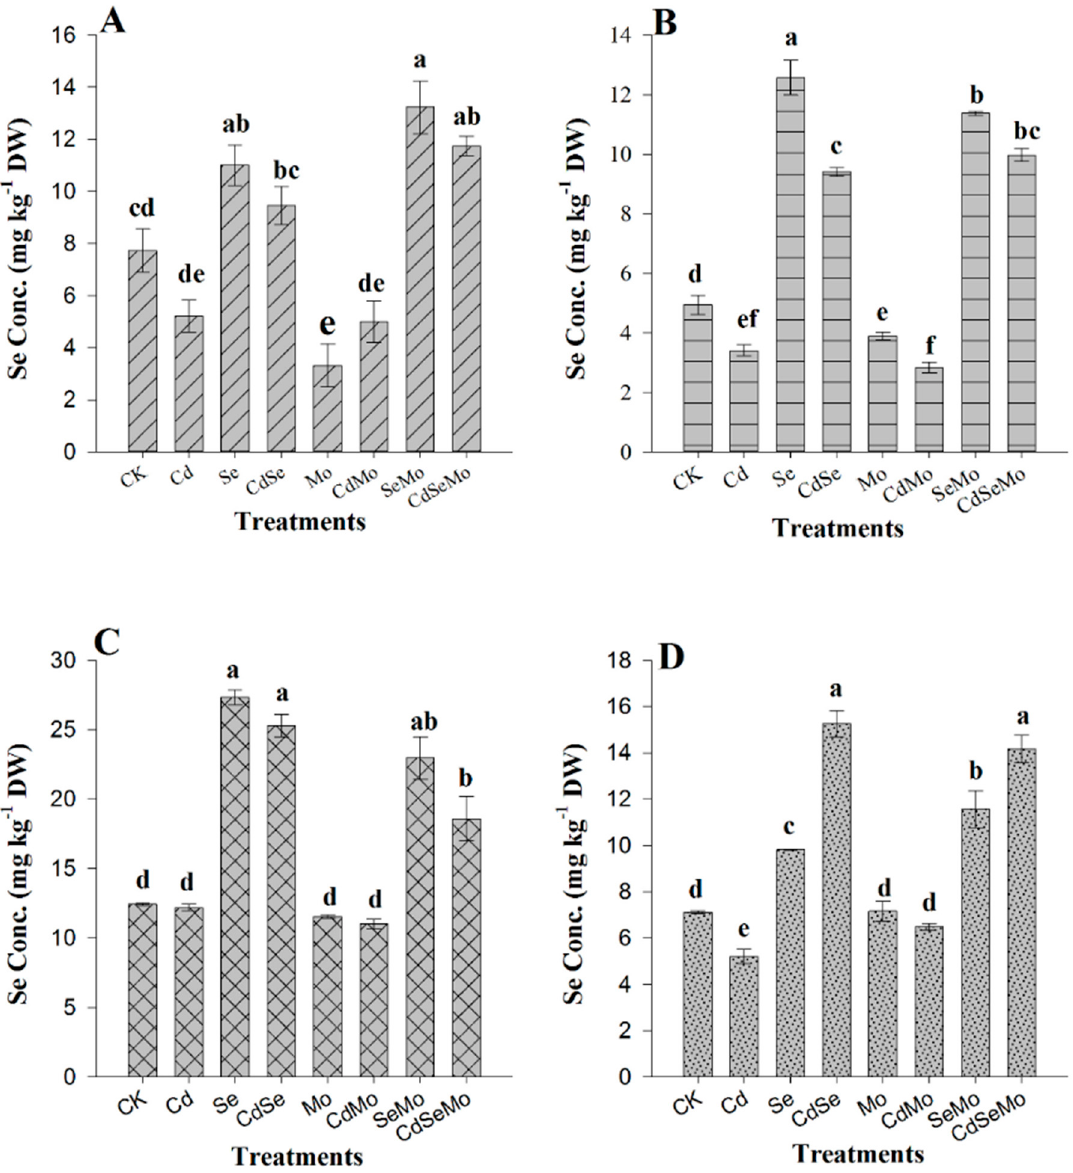
Figure 3. Concentrations of Se in B. napus tissues under different treatment conditions. Se content in root ( A ), stem ( B ), glume ( C ), and seed ( D ) of oilseed rape treated with foliar spray of (1 mg/L) Se and/or (0.3 mg/L) Mo in absence or presence of Cd stress (5 mg/kg). All data show the means ± SD of four replicates. Different letters within a column indicate significant ( p < 0.05) differences between treatments.